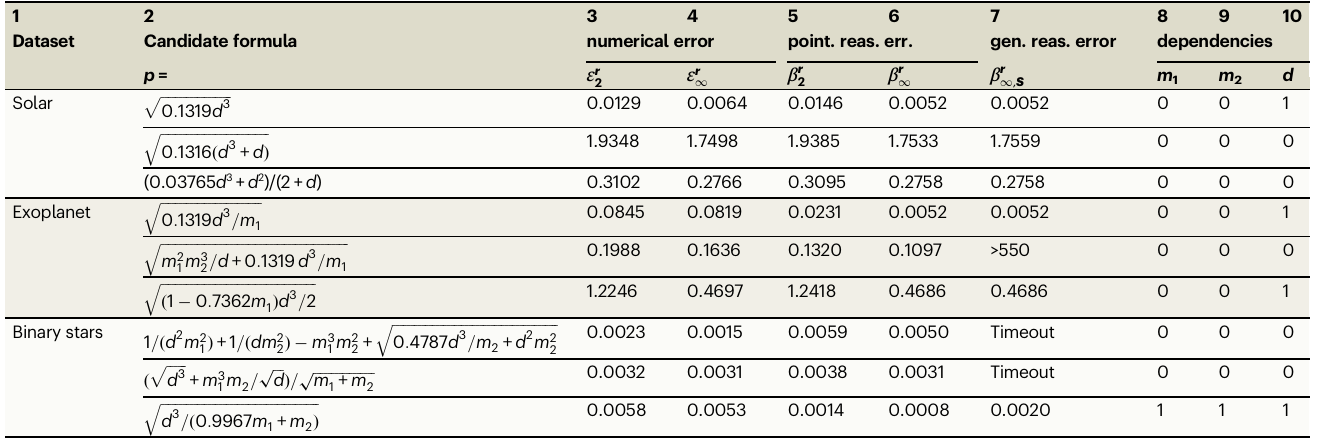
Numerical errorvalues, pointwisereasoning errorvalues, and generalization errorvalues are shown. Wealso give an analysis of the variable dependence ofcandidatesolutions.Forsimplicity of notation, in the table weusethevariables d , m 1 , m 2 and p , while referring to the scaled counterparts.Weassume that allthe errors are